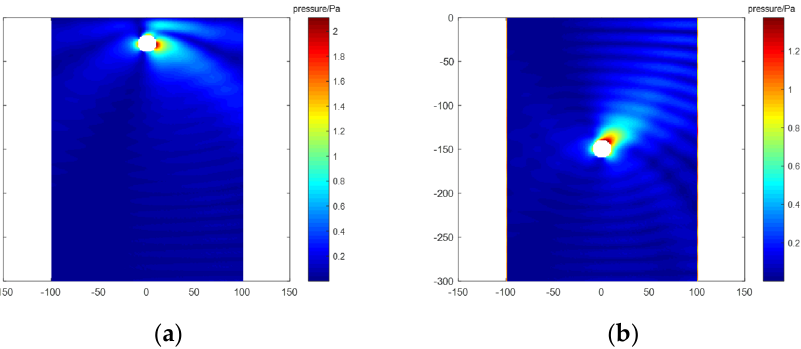
Figure 5. Schematic of equivalent theory of directional point source. ( a ) The target 20m away from the interface ( b ) The target 30 m away from the interface ( c ) The target 180 m away from the interface